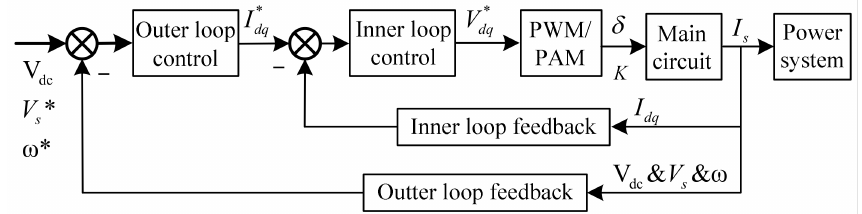
Figure 2. A STATCOM control